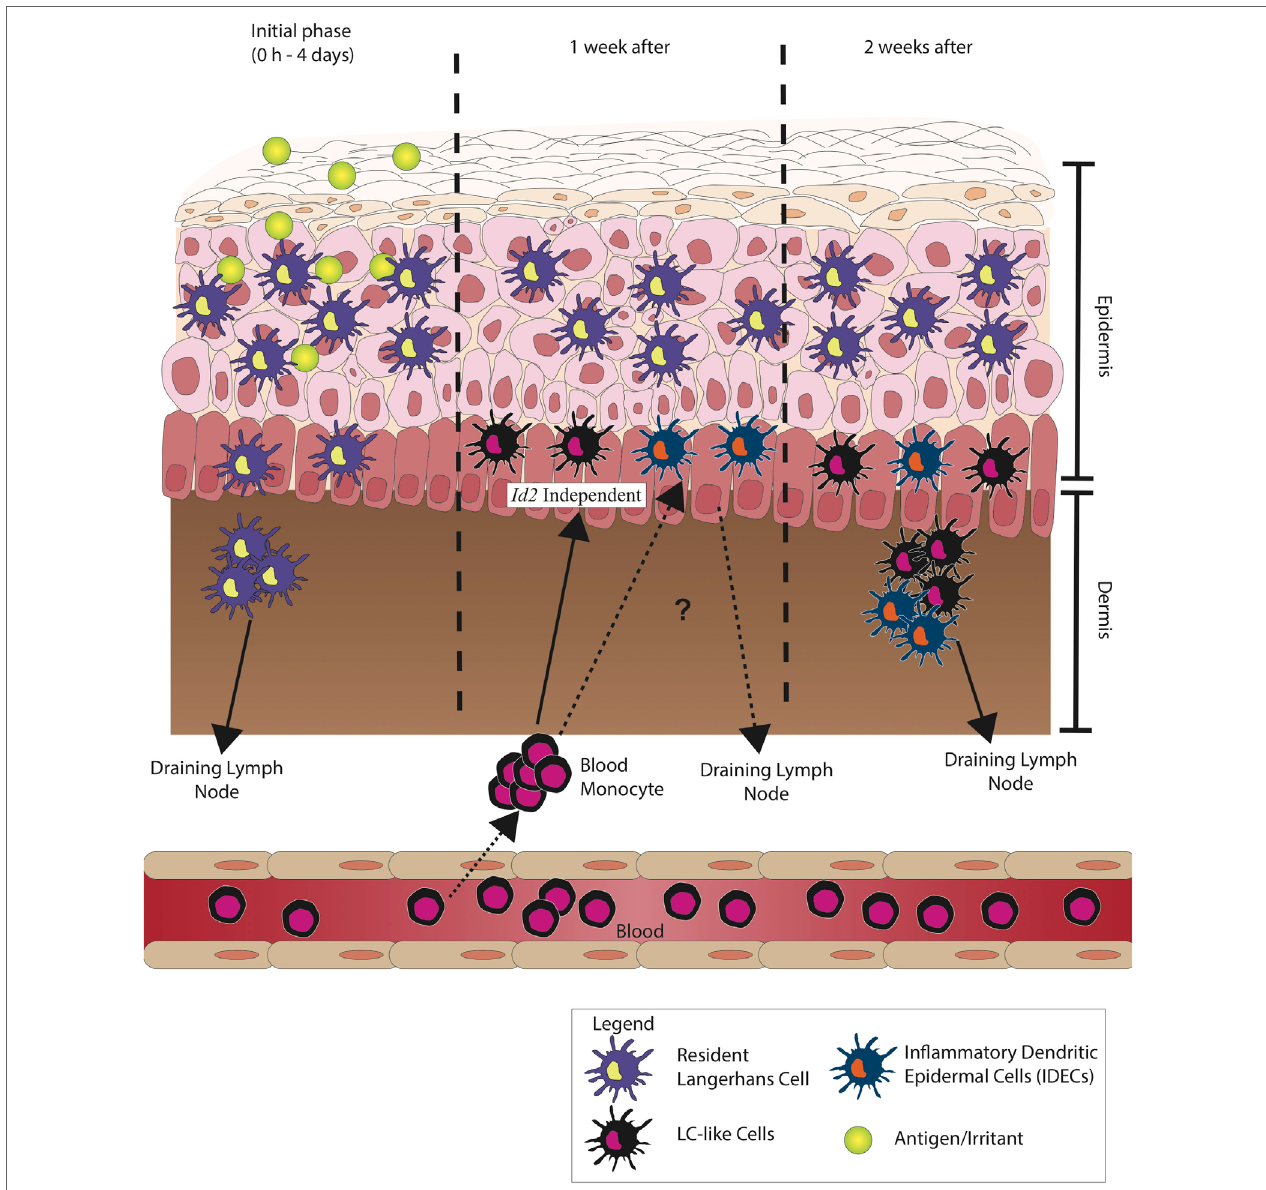
FiGURe 2 | Langerhans cells (LCs) during inflammation. During the initial phase of inflammation, LCs migrate to the draining lymph node, but unlike conventional/ classical dendritic cells (cDCs), LCs are observed to peak in number at day 4 after initial sensitization to antigen. The migration of LCs has been observed to be much slower. After 1 week, it is believed that inflammatory dendritic epidermal cells (IDECs) increase in number. These circulating blood monocytes from the bone marrow differentiate to LC-like cells and do not depend on transforming growth factor- β (TGF- β ) signaling pathway but are morphologically and phenotypically very similar to resident LCs. IDECs reside in the epidermal–dermal junction, and after 1 week of recruitment, they most likely migrate into the draining lymph node. These show the probable functional difference between LCs and IDECs as the kinetics of recruitment and migration between the two cells is